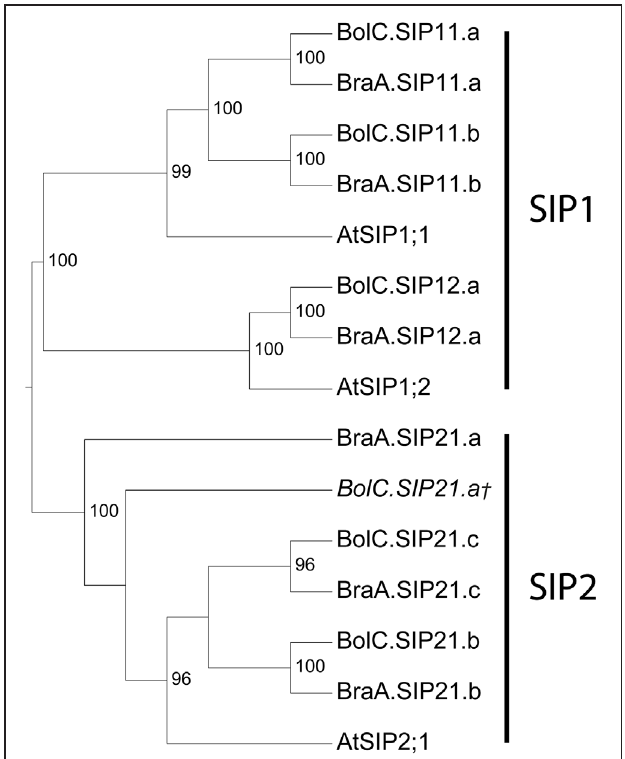
FIGURE 5 | Phylogeny of SIPs. Phylogenetic tree derived from SIP cDNA sequences of B. oleracea , B. rapa, and A. thaliana using Bayesian phylogenetic inference. Numbers beside the nodes indicate the posterior probability values > 75%. Gene IDs which are written in italics and/or marked with a cross ( † ) do not encode for full-length AQPs due to mutations leading to frameshifts or stop codons in their sequence.